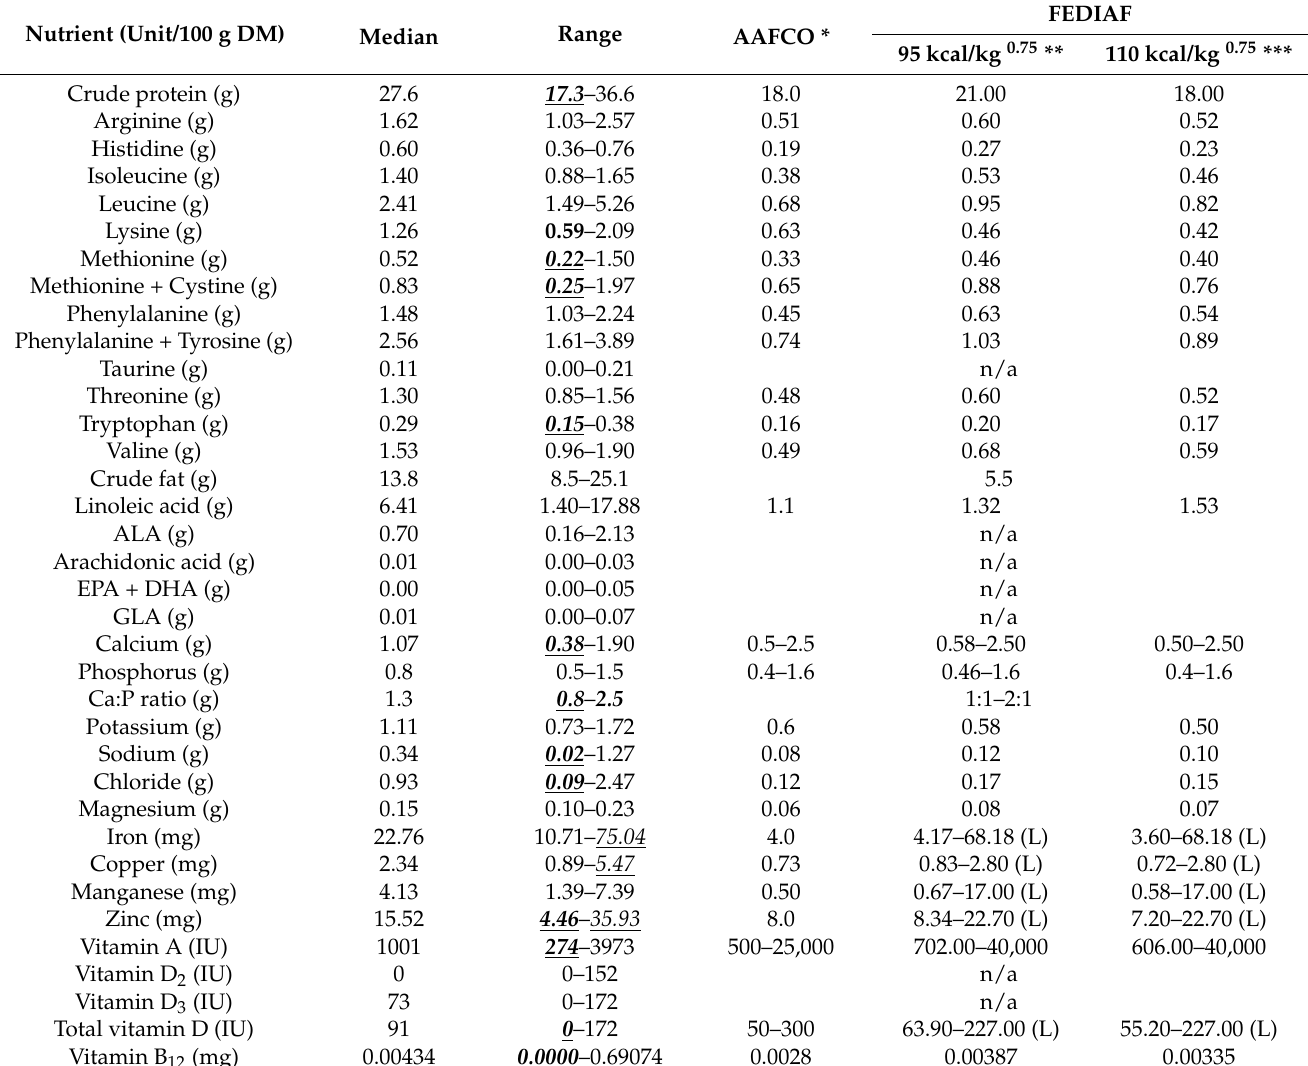
Table 1. Measured nutrient content in 20 plant-based canine foods commercially available in Canada and labeled for adult or all life stages compared to the AAFCO and FEDIAF recommended essential nutrient concentrations for canine adult maintenance on a dry matter basis (unit per 100 g dry